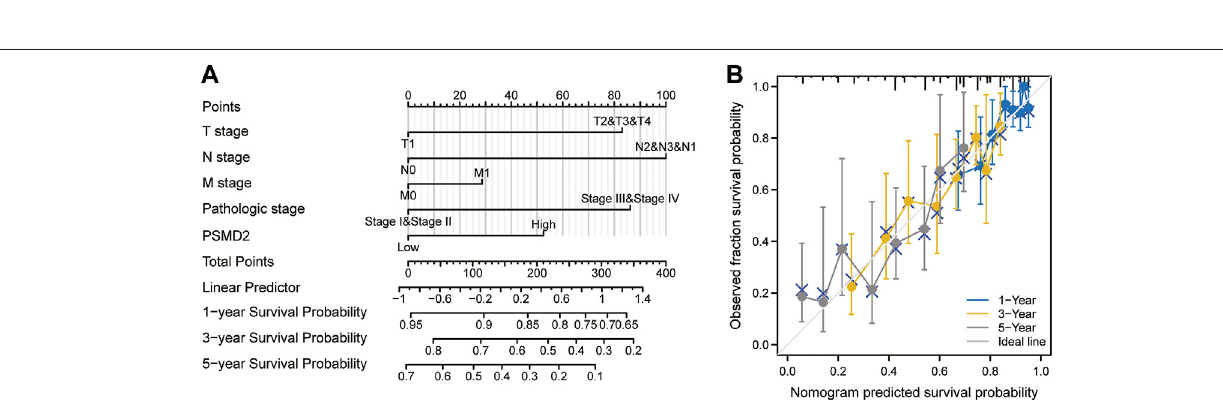
Frontiers in Genetics |